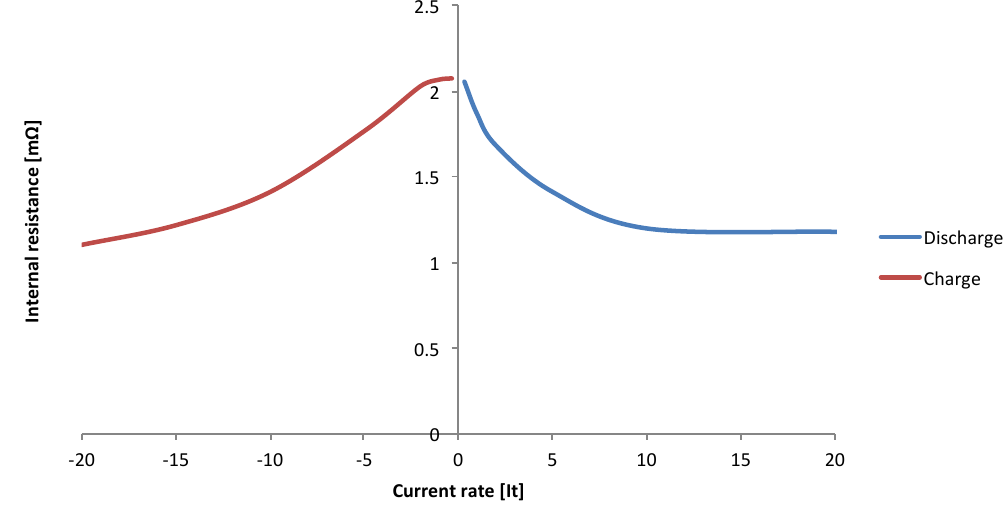
Figure 10. Butler-Volmer phenomenon at lithium-ion cell